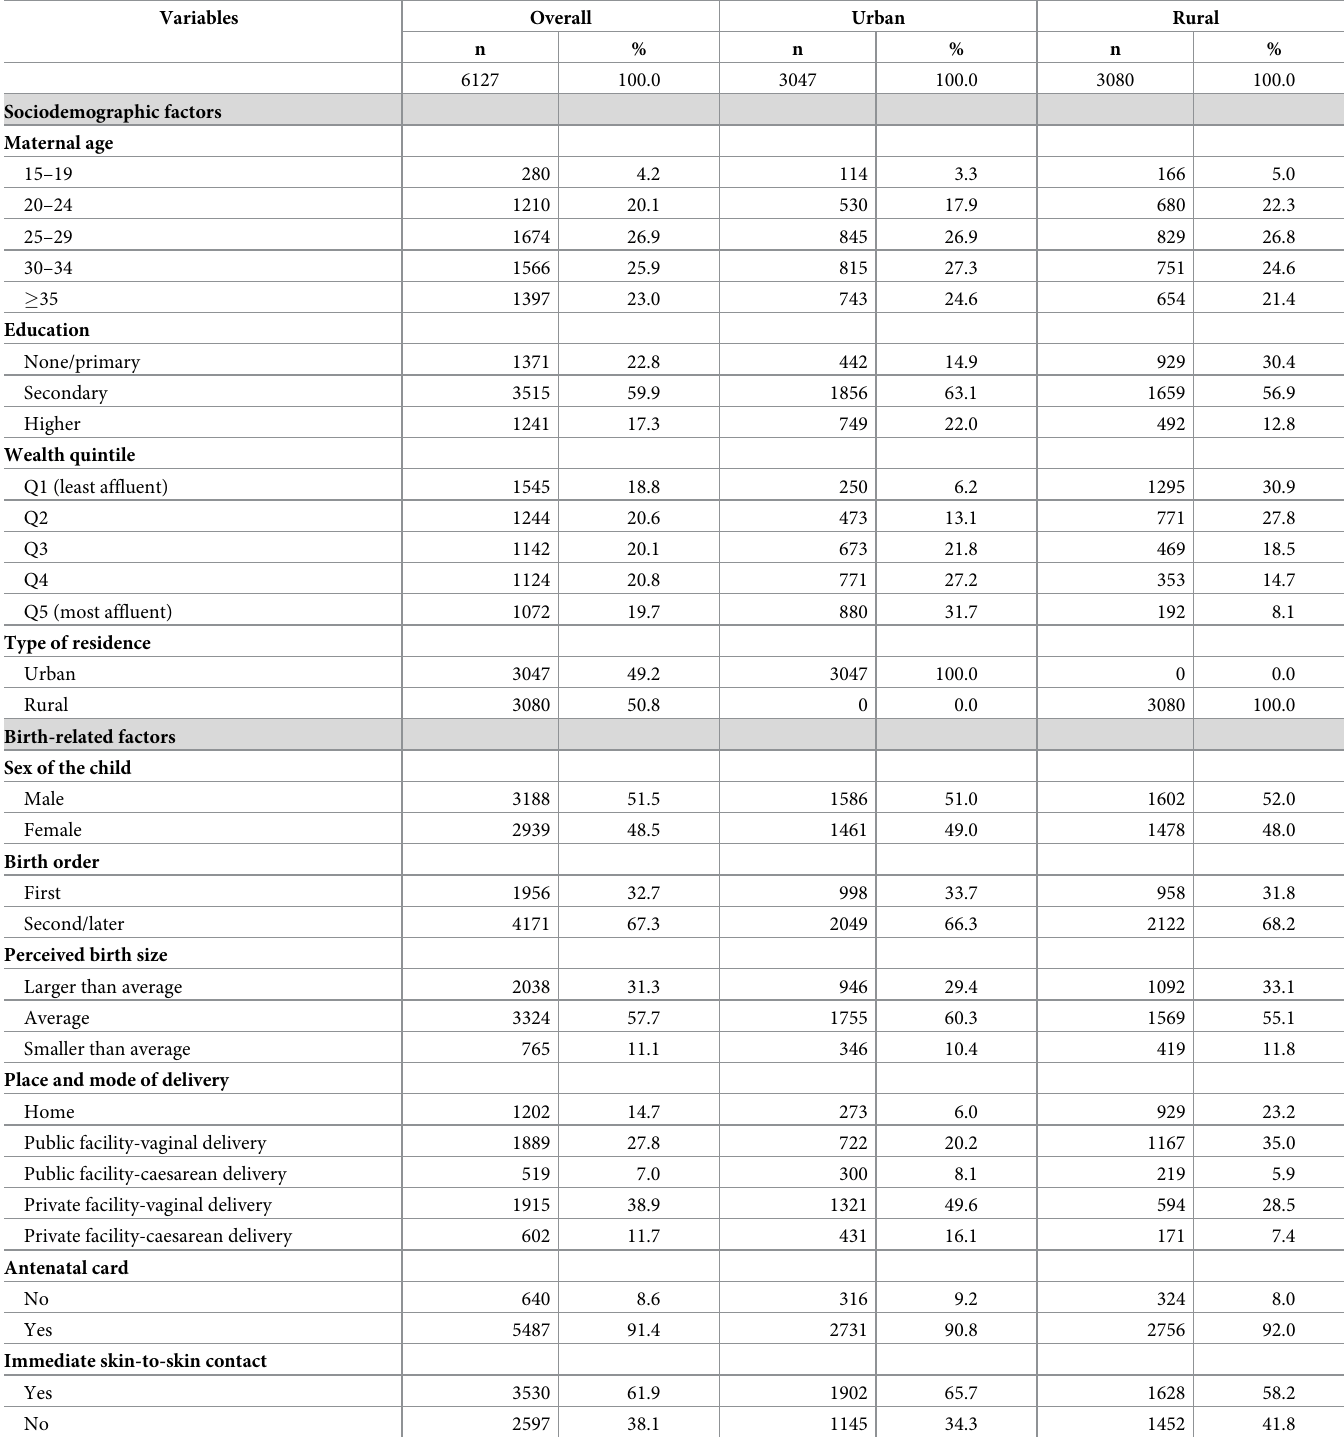
Table 1. Distribution of study population, overall and by type of